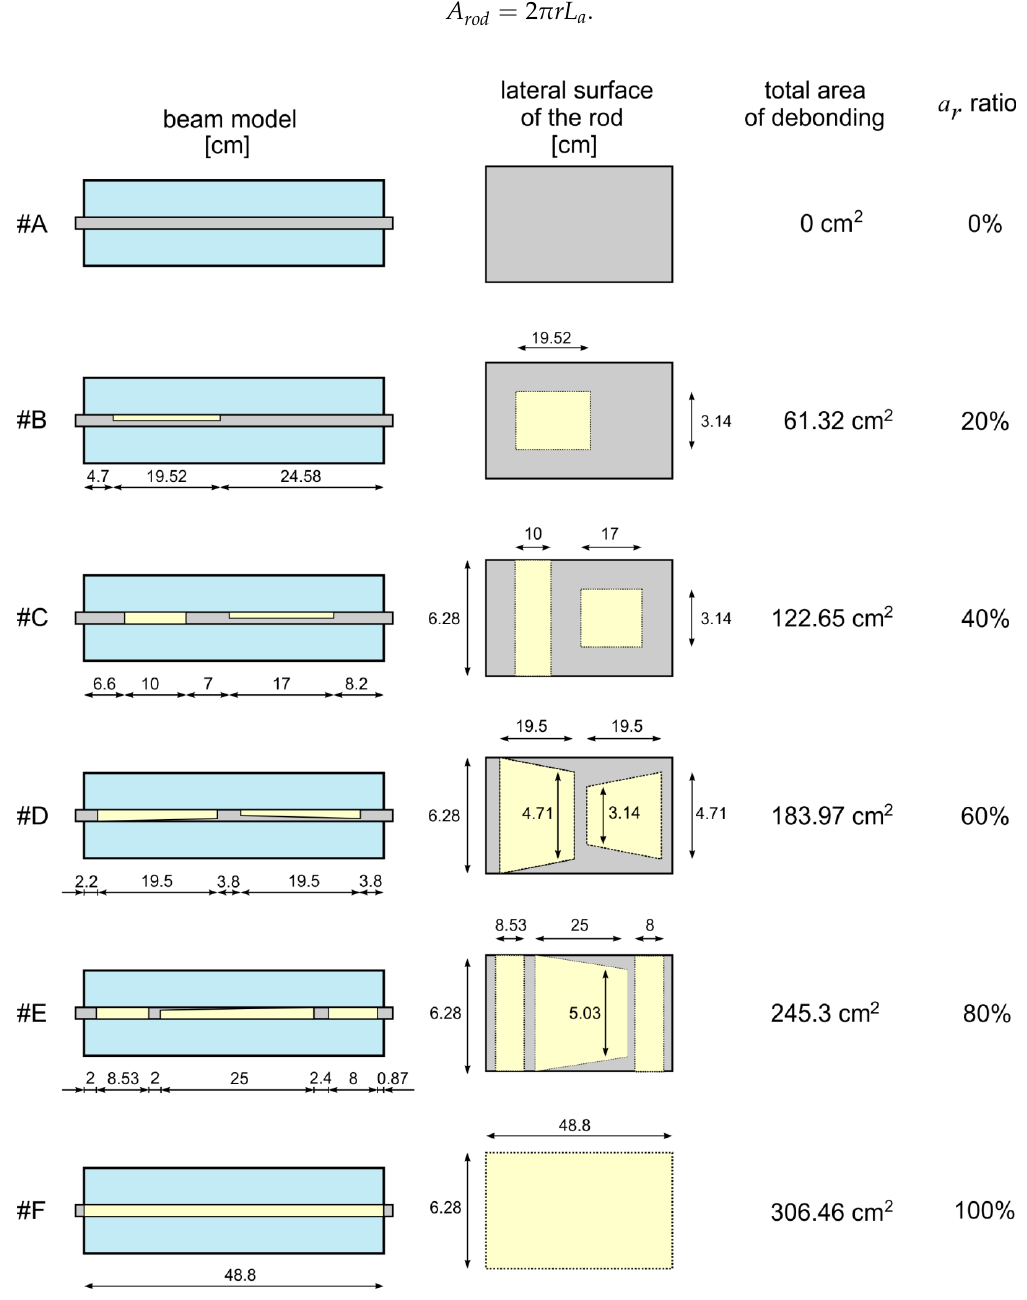
Figure 8. Damage scenarios considered in experimental tests: Beam with debonding of area equal to #A 0%, #B 20%, #C 40%, #D 60%, #E 80% and #F 100% of the total surface area of the rod embedded in concrete block.